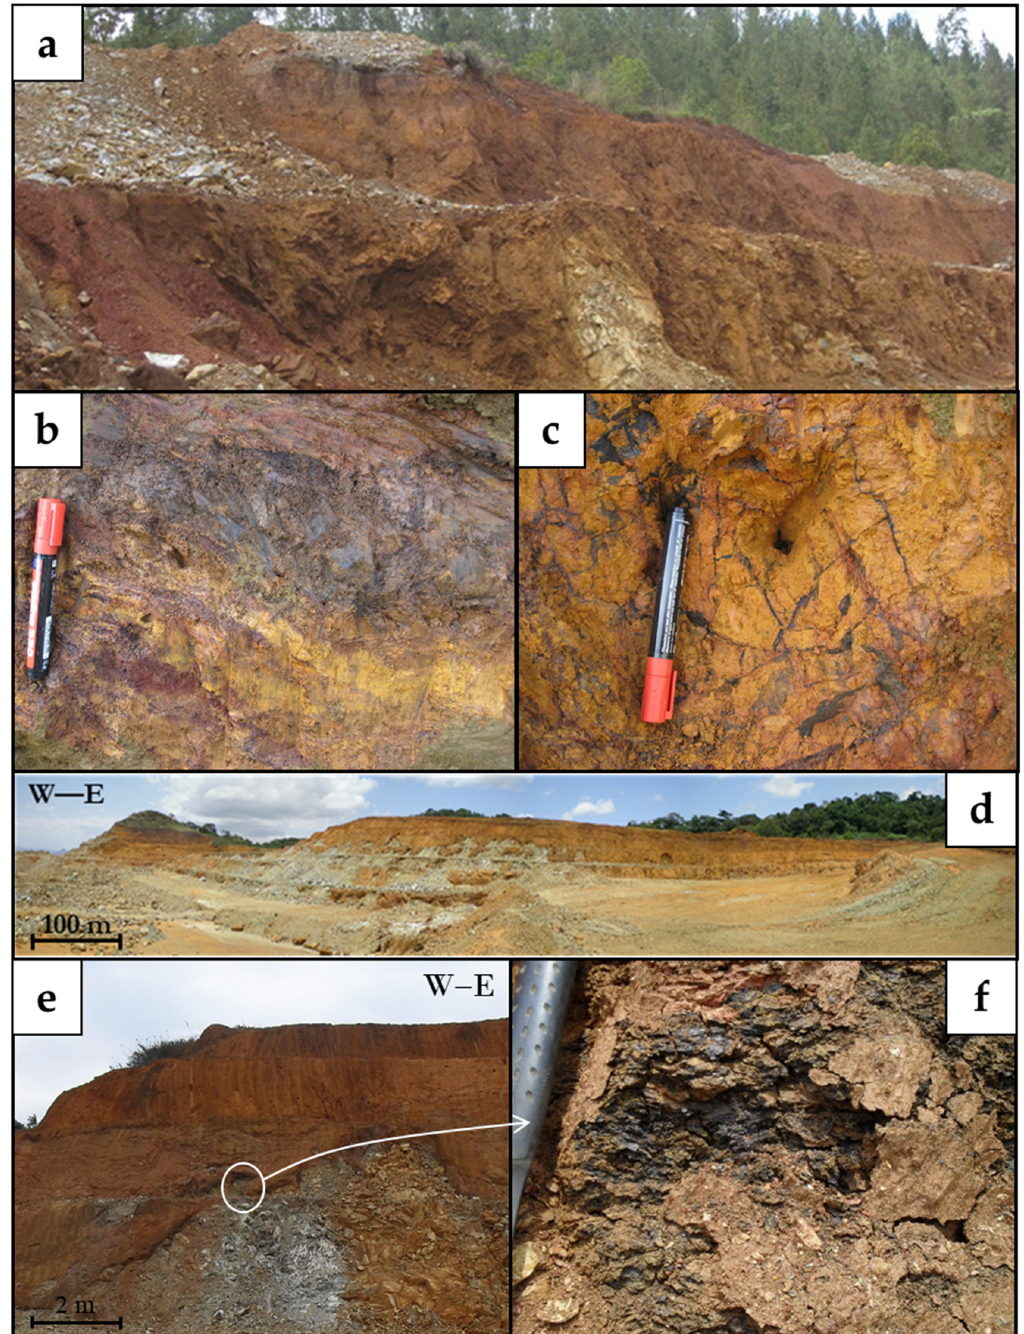
Figure 3. Field occurrence of Co–Mn mineralisations in Loma Caribe ( a – c ) and Loma de Hierro ( d – f ). Panorama view of the mining pits ( a , d , e ) and close-up views of Co–Mn mineralisations ( b , c , f